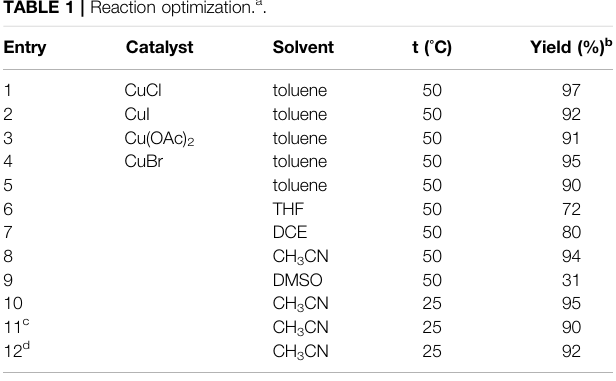
TABLE 1 | Reaction optimization. a